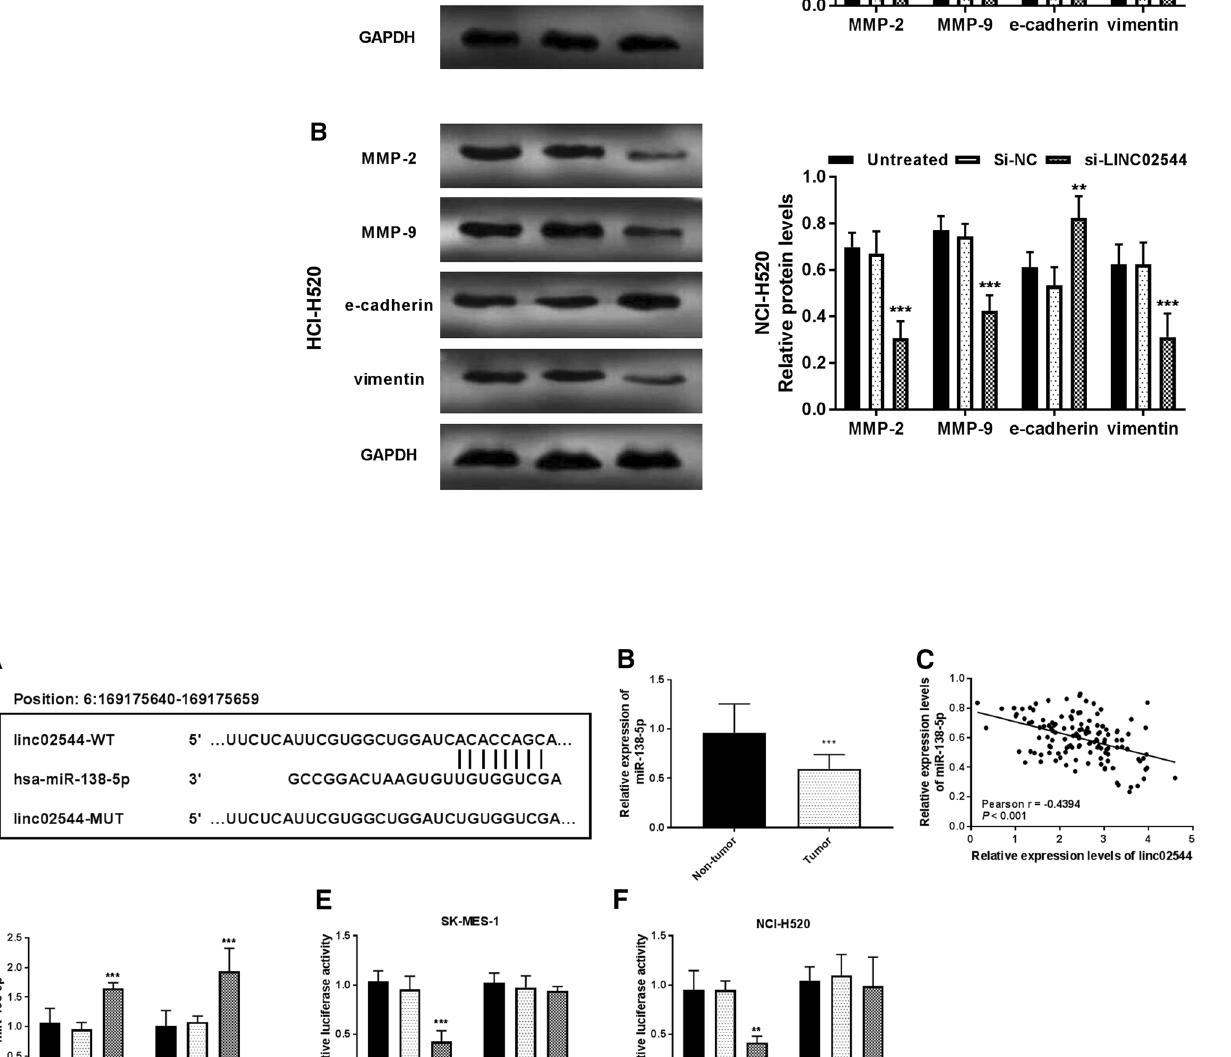
Fig. 3 The metastasis-related protein levels were measured using a Western blot assay. A and B The MMP-2, MMP- 9, and vimentin levels were decreased while E-cadherin levels were increased in cells transfected with si-linc02544